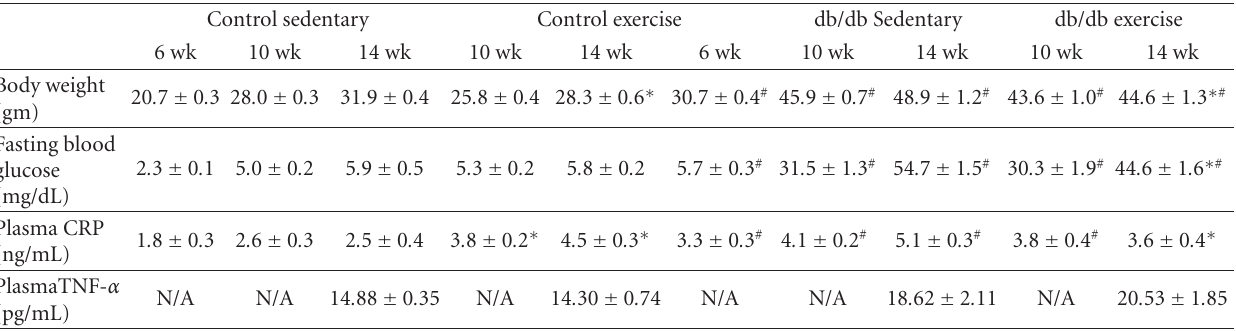
Table 1: Body weights, plasma glucose CRP, and TNF- α levels in control or diabetic (db/db) mice that were either sedentary or exercised. Control sedentary Control exercise db/db Sedentary db/db